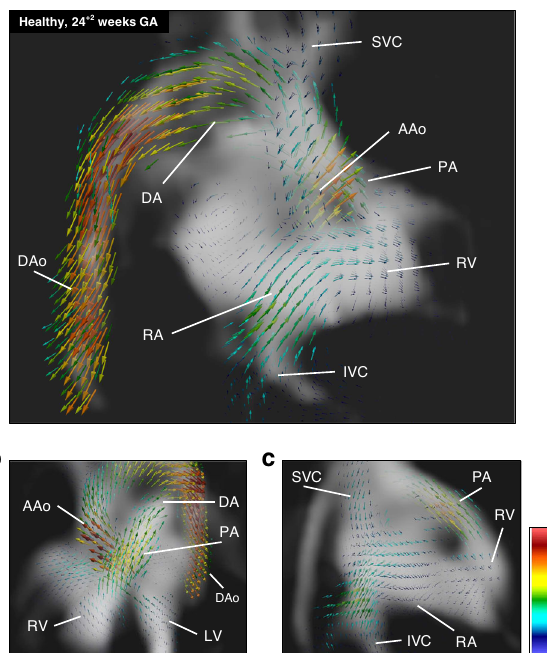
Fig. 4 Whole heart 4D blood fl ow in a healthy fetus. Volumetric 4D fl ow renders showing three-directional fl ow velocity vectors in subject ID03 (healthy fetus 24 + 2 weeks gestational age) overlaid on 4D magnitude cine renders, during end-ventricular systole. a Aortic arch view showing blood fl ow vectors emerging from the ascending aorta (AAo), fl owing around the arch and through the descending aorta (DAo). b Long-axis view showing blood fl ow through the crossing AAo and pulmonary artery (PA). c Right- sided view showing right atrium (RA) in fl ow from the superior vena cava (SVC) and inferior vena cava (IVC), which subsequently mixes and passes through to the right ventricle (RV) before fl owing out of the pulmonary artery (PA). See Supplementary information for movies of the views in this fi